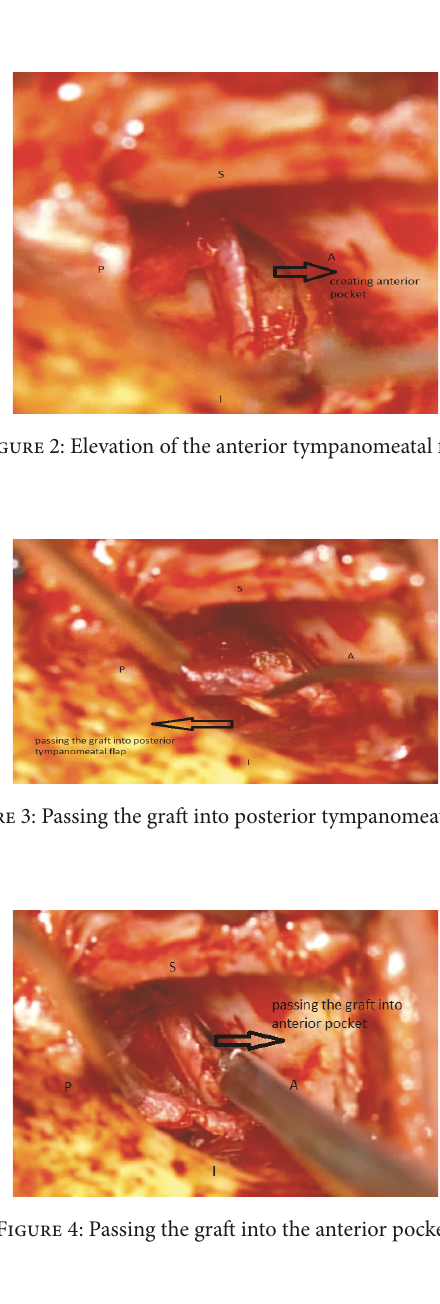
Figure 1: Elevation of the posterior tympanomeatal flap: A = ante- rior, P = posterior, and S = superior.